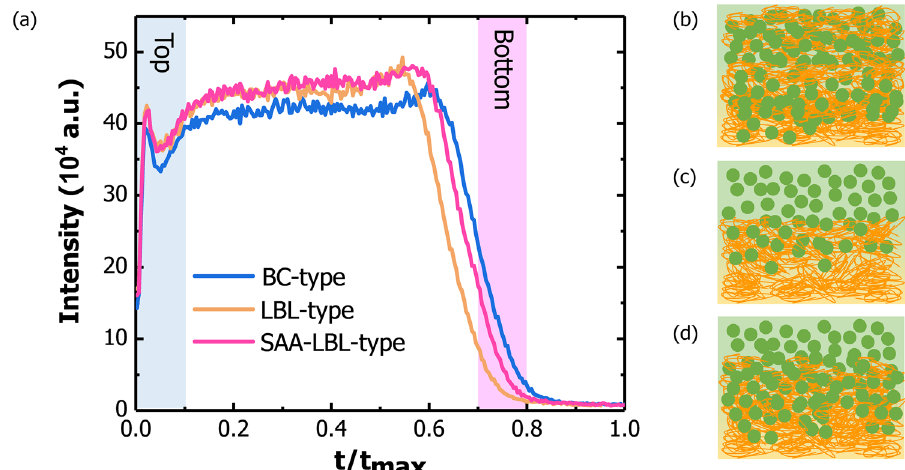
Fig. 3 a TOF–SIMS ion yield of CN − as a function of sputtering time for BC-type, LBL-type and SAA-LBL-type blend films. b Diagram of BC-type morphology. c Diagram of LBL-type morphology. d Diagram of SAA-LBL-type